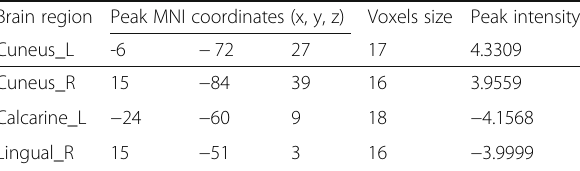
Table 3 Significant differences in ICA-Z value within visual areas between two